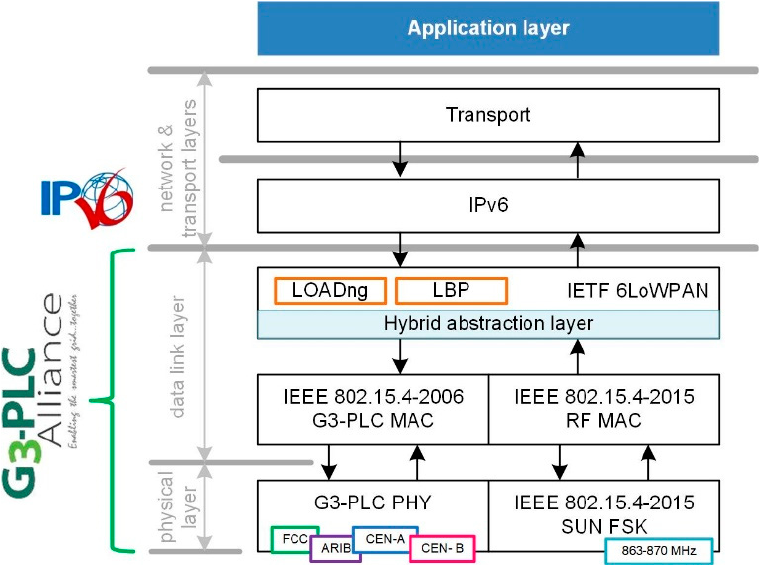
Figure 14. The G3-PLC Hybrid PLC & RF protocol stack.